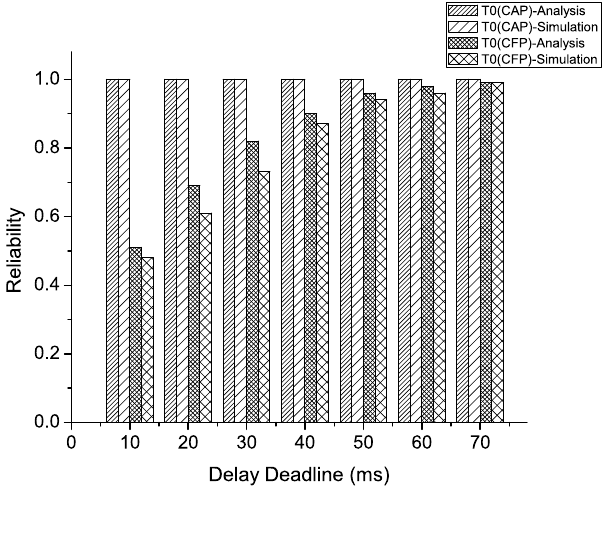
Figure 17. Comparison of analytical and simulation results on reliability performance of emergency traffic for different delay